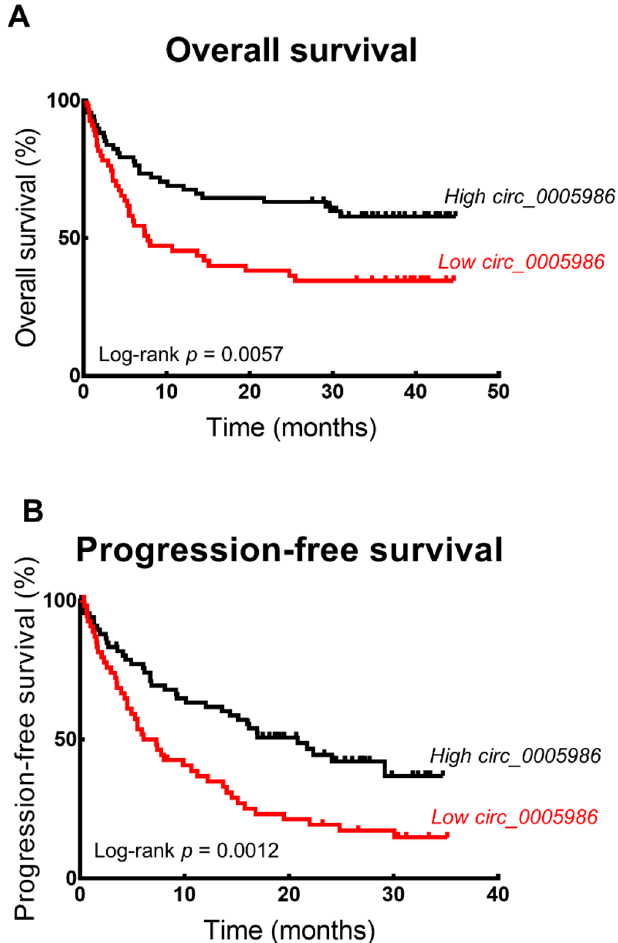
Figure 4. Survival curves according to hsa_circ_0005986 expression. Overall survival ( A ) (log-rank test, p = 0.0057) and progression-free survival ( B ) (log-rank test, p = 0.0012) rates were decreased in the high hsa_ circ_0005986 expression group.